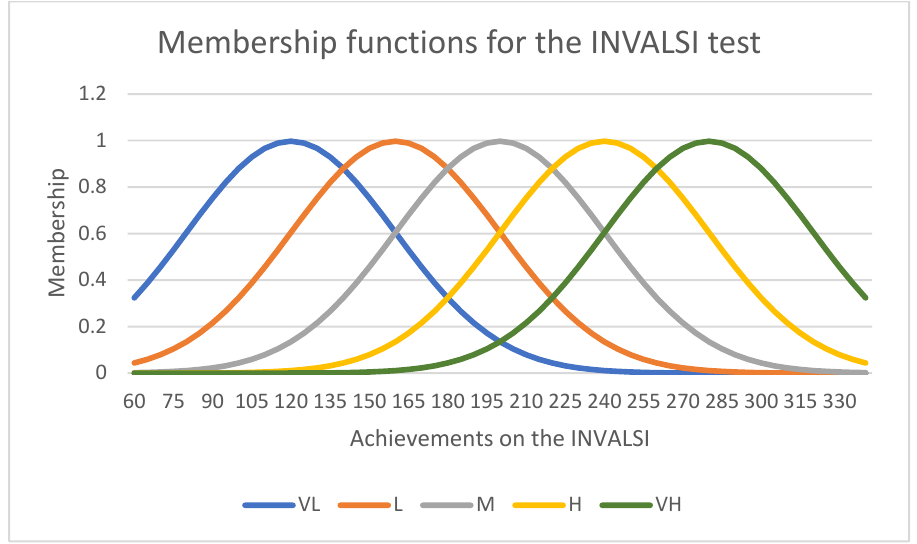
Figure 4. The plots of the membership functions for the INVALSI test.